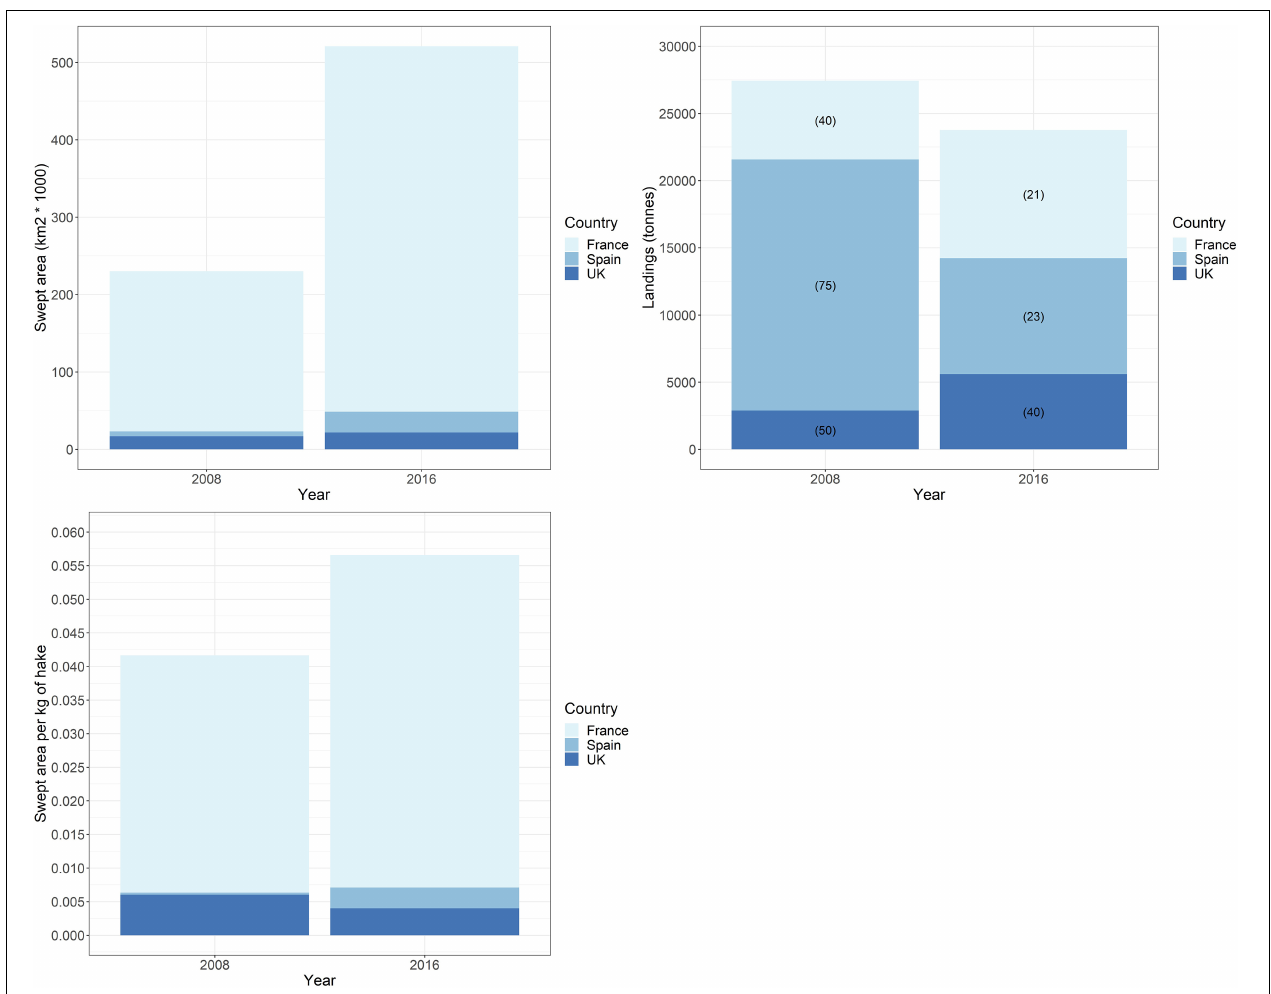
FIGURE 3 | (Top left) Swept area by otter trawls by country for 2008 and 2016 (STECF, 2017). (Top right) Hake landings by “DTS” by country, with percentage of total hake landings in parenthesis, for 2008 and 2016 (STECF, 2020b). (Bottom left) Swept area per kg of hake by country for 2008 and